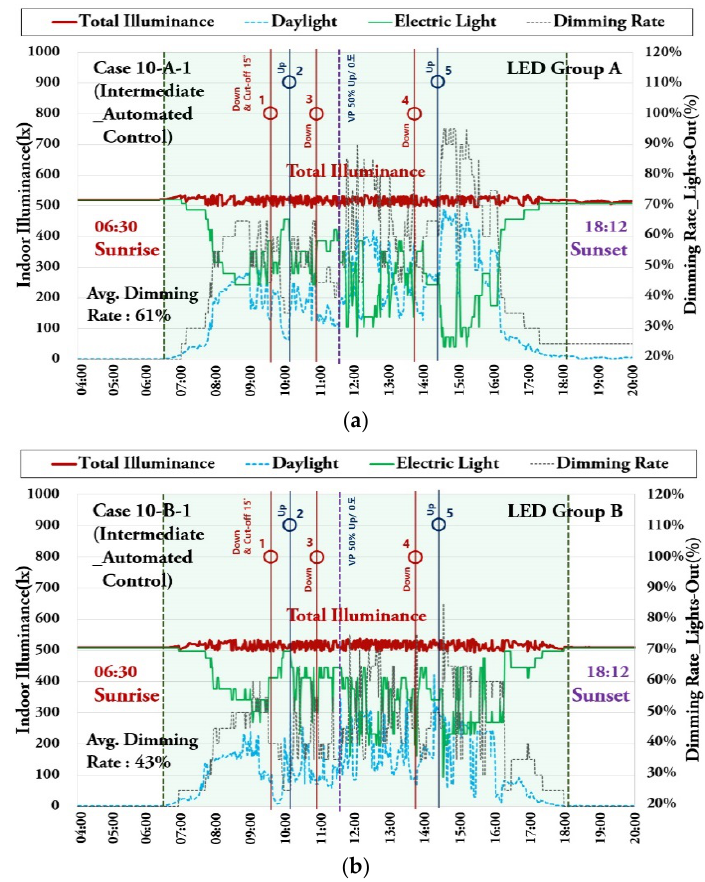
Figure 22. Illuminance and dimming rates under dimming controls integrated with automatic blind control. (intermediate sky_10.08). ( a ) Case 10-A-1 and ( b ) Case 10-B-1 in Table 7.